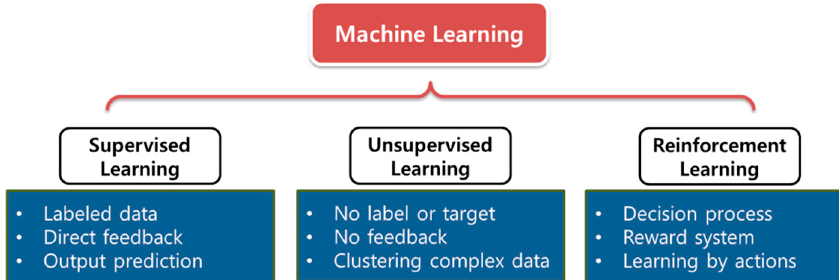
Figure 1. Machine learning categories.